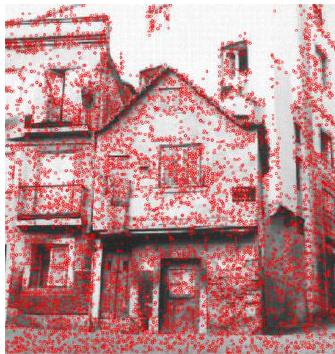
Figure 8. Case study No.1: Manual selection of feature points (step 2 in Figure 7) Figure 11. Case study No.1: Measurements from on-site survey used for model scaling the model (DE) and metric comparison.